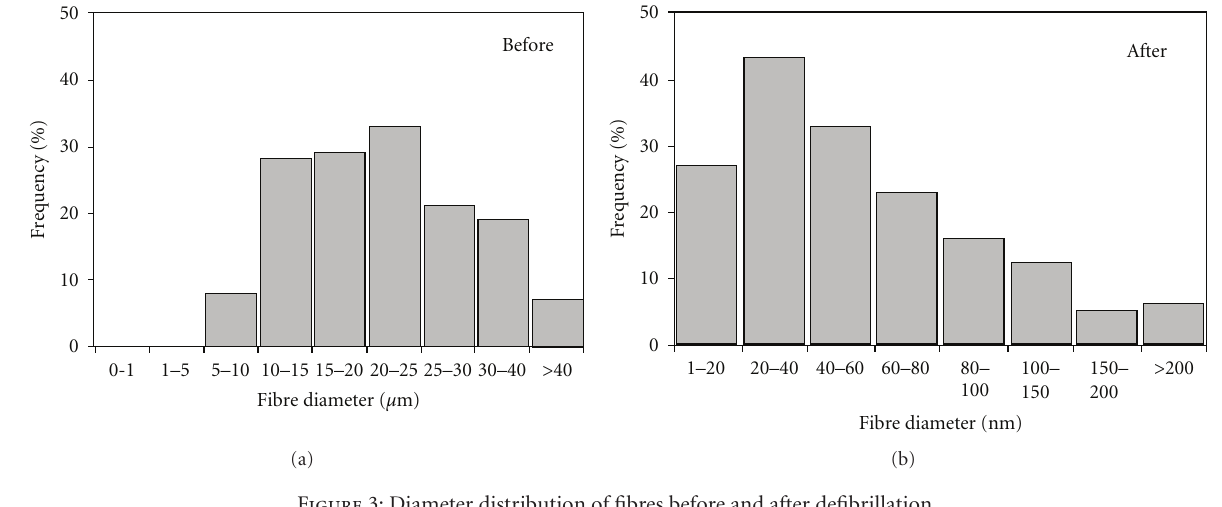
Figure 3: Diameter distribution of fibres before and after defibrillation.